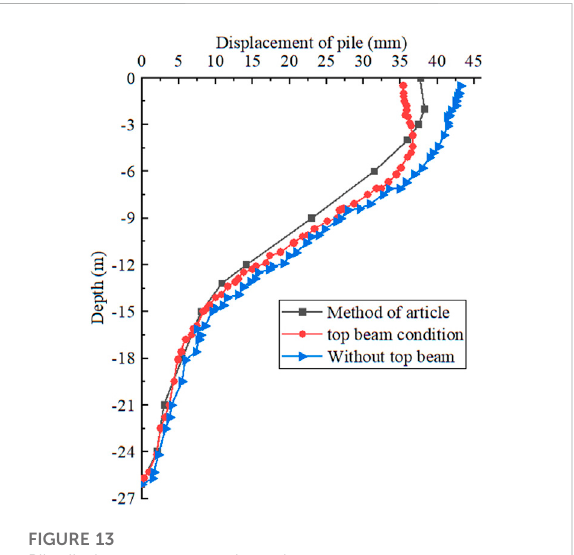
FIGURE 13 Pile displacement comparison